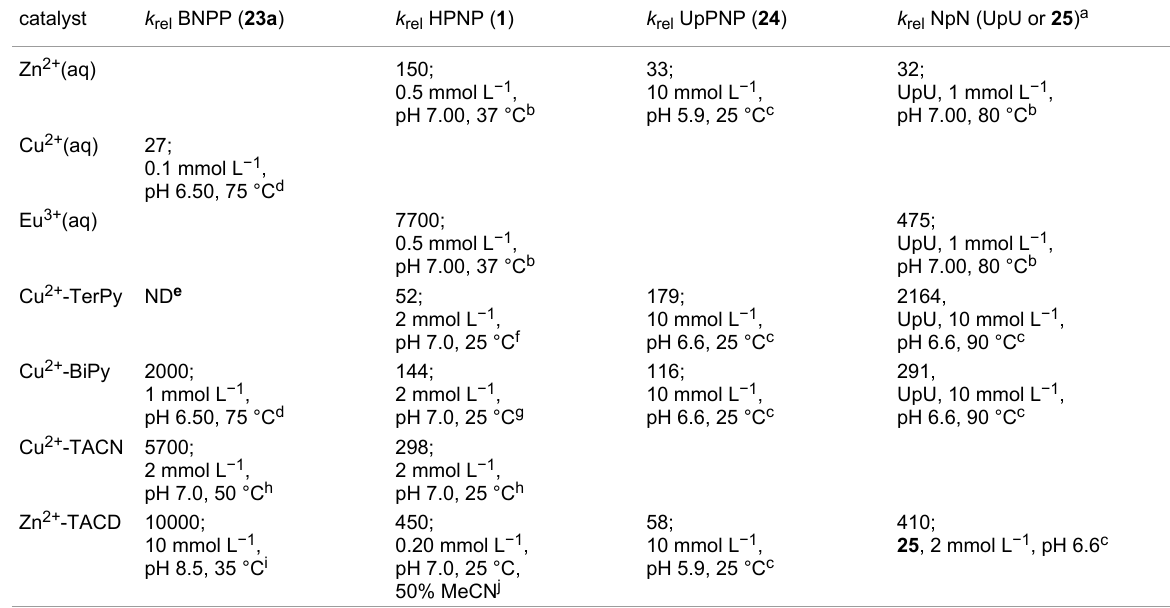
Table 2: Catalytic activity ( k rel = k obs / k uncat ) of chosen metal ions and their complexes under given conditions ([catalyst], pH and temperature).